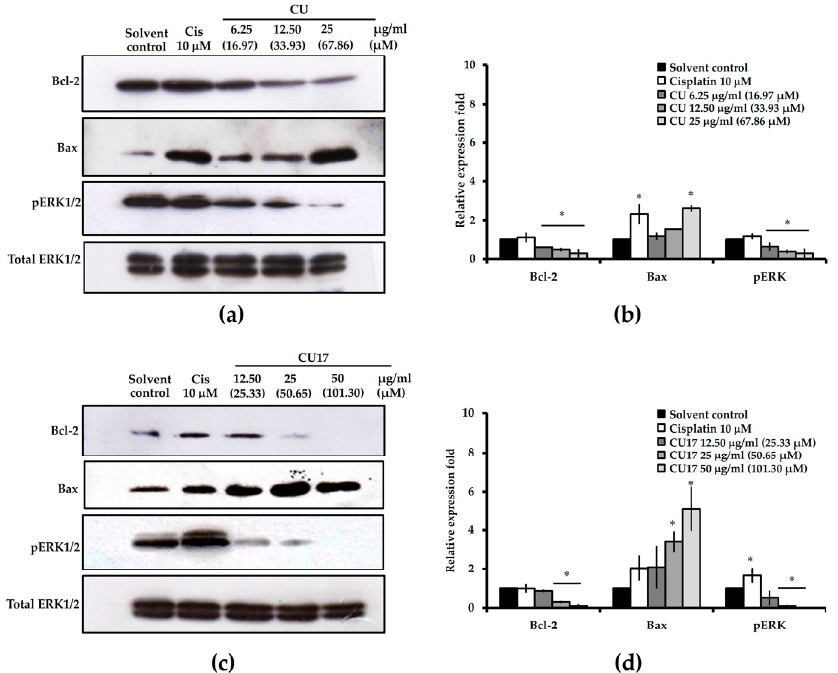
Figure 8. Western blot analysis of apoptosis-related and ERK signaling proteins in A549 cells. ( a , c ) Cells were exposed to various concentrations of CU or CU17 for 24 h. DMSO: ethanol (1:1, v / v ) and cisplatin (10 µM) were used as negative and positive controls, respectively. Total ERK1/2 was used as a loading control for Western blotting. The representative blots are from one experiment. ( b , d ) The relative fold of protein expression was calculated using the intensity of the protein band in comparison to that of a loading control and shown as a bar graph. Bar graphs display the mean from three independent experiments. * p < 0.05 indicates a significant difference between the treatment and solvent control.